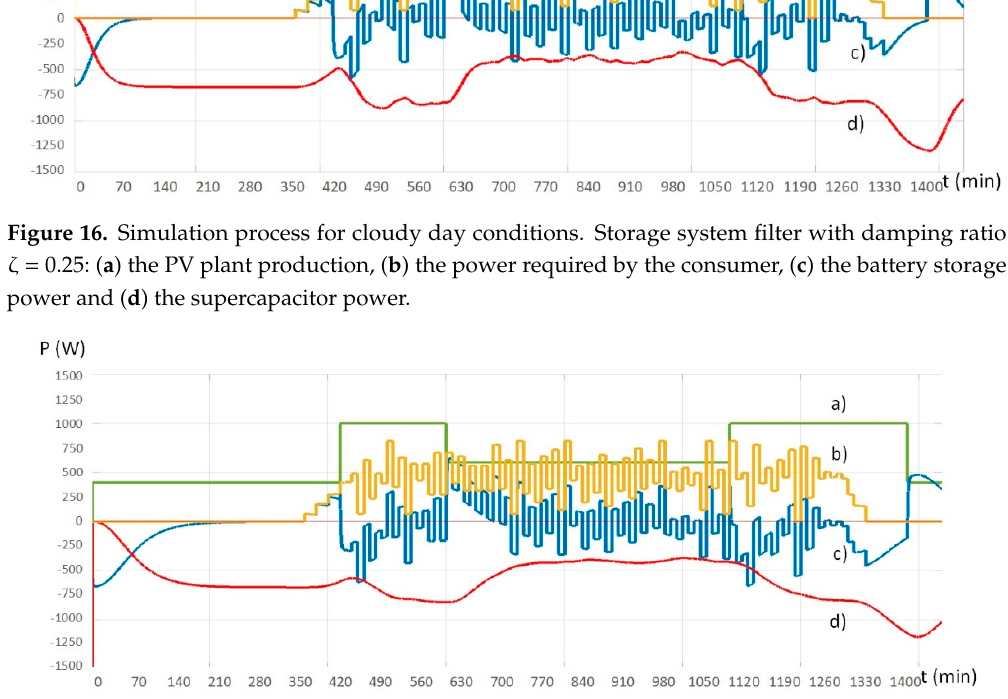
Figure 17. Simulation process for cloudy day conditions. Storage system filter with damping ratio ζ = 0.5: ( a ) the PV plant production, ( b ) the power required by the consumer, ( c ) the battery storage power and ( d ) the supercapacitor power.